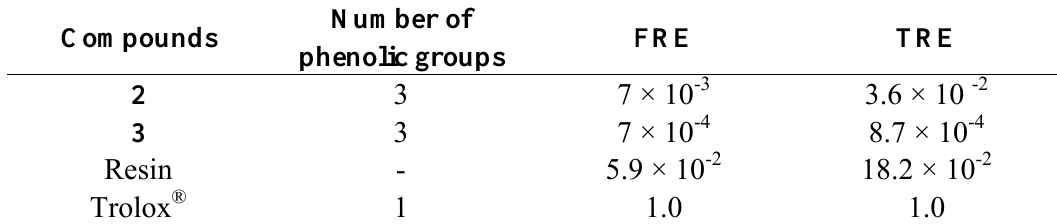
Table 1. Experimentally determined indexes of FRE and TRE for the reaction of the DPPH radical with the isolated compounds 2 and 3 and the resinous exudates from Heliotropium